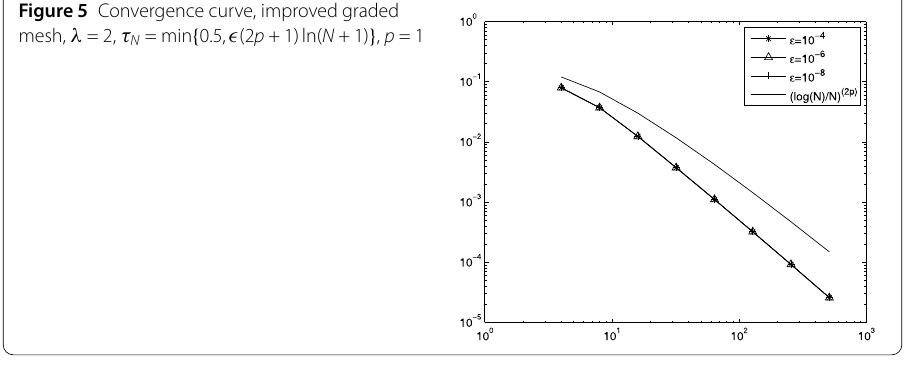
Figure 5 Convergence curve, improved graded mesh, λ = 2, τ N = min { 0.5, (cid:2) (2 p + 1)ln( N + 1) } , p = 1